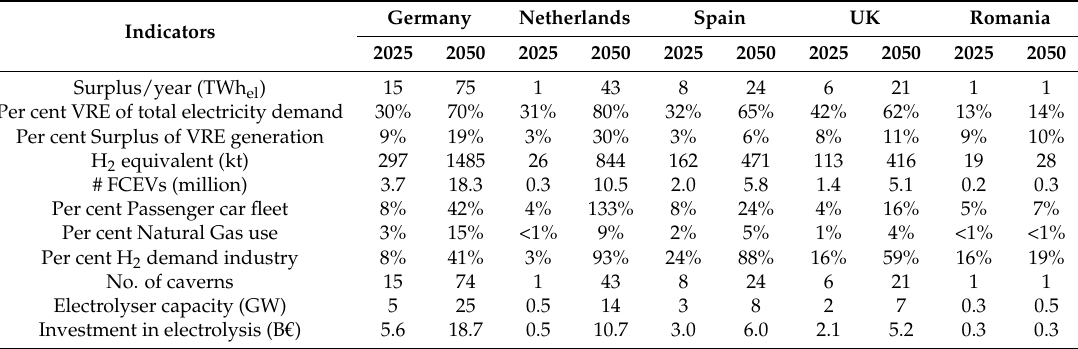
Table 2. Overview of Hyunder case study assessments in five EU countries.